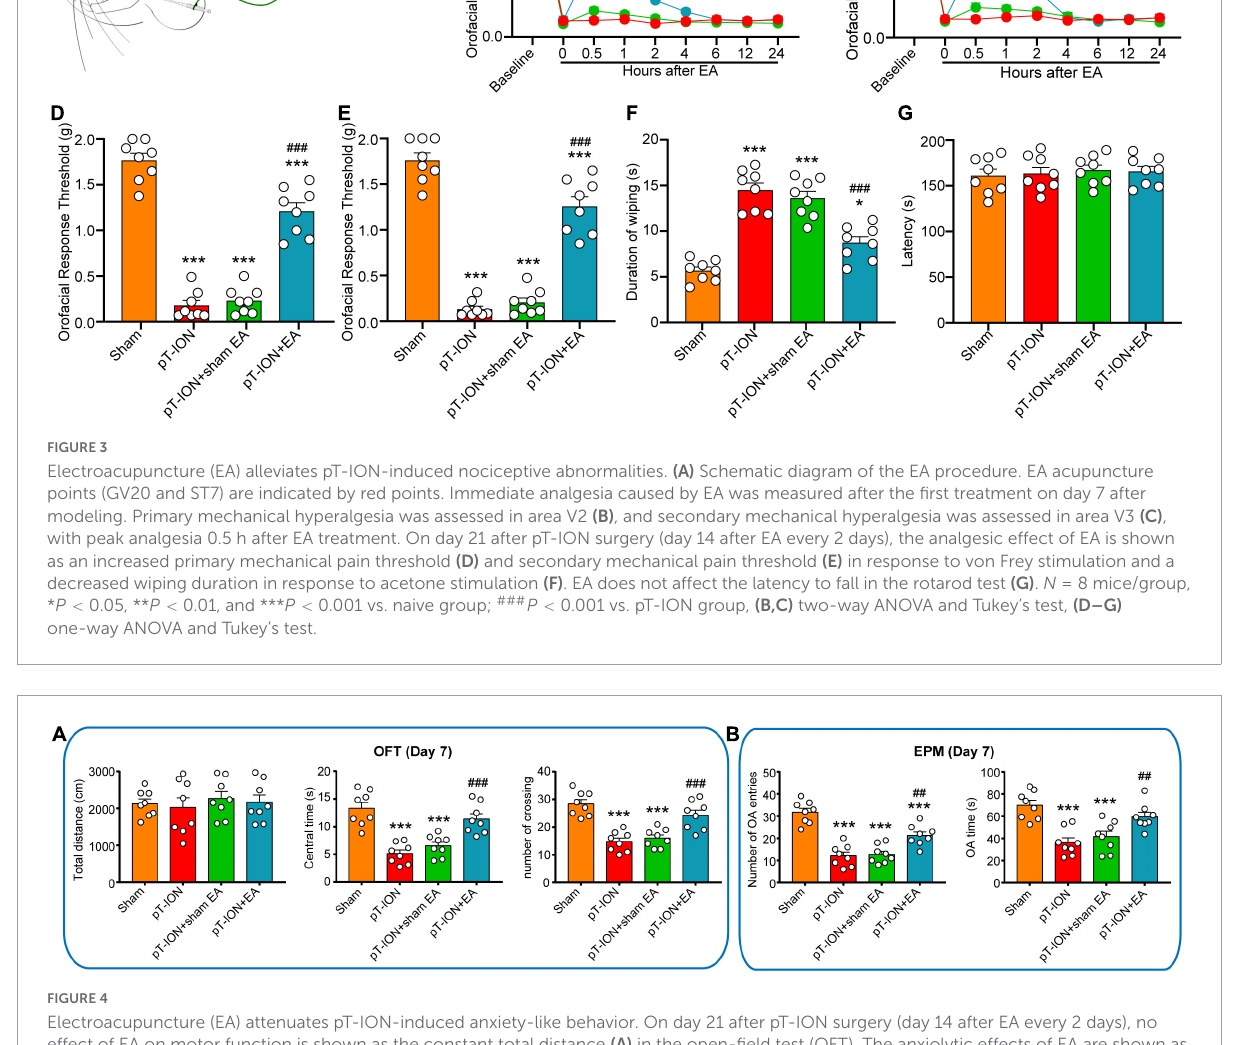
pT-ION group compared to the sham group (total dendritic spines: F = 42.38, P < 0.0001; mushroom-type dendritic spines: F = 43.32, P < 0.0001; one-way ANOVA and Tukey’s test; Figures 5B–D ). EA treatment significantly increased the densities of total dendritic spines and mushroom-type dendritic spines in the CA1 region of pT-ION mice ( Figures 5B–D